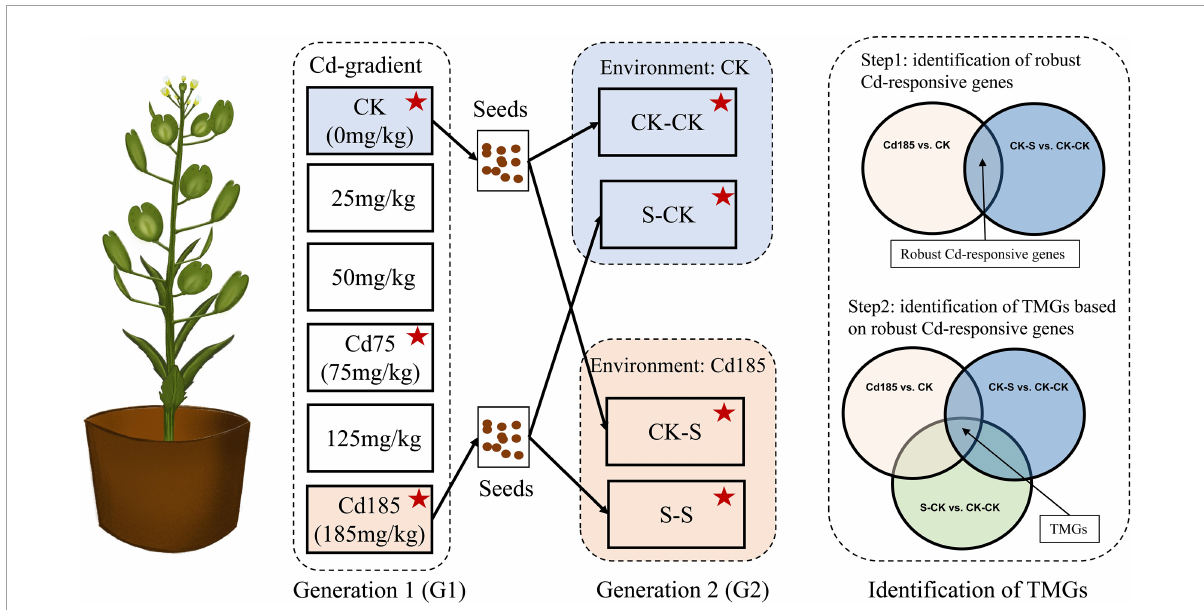
FIGURE1 Experimental design. In G1, seedlings from maternal plant were treated with a gradient of Cd from 0 to 185 mg/kg. Seeds collected from CK and Cd185 were used to conduct experiment in G2 that treated offspring seedlings with CK and Cd185. Several morphological traits, reproductive traits and physiological traits of all individuals were measured, and samples marked by red star were further used for RNA sequencing. Transcriptional memory genes (TMGs) were identified by screened genes that showed the same expression pattern (both upregulated or downregulated) between Cd185 vs. CK, CK-S vs. CK-CK, and S-CK vs. CK-CK